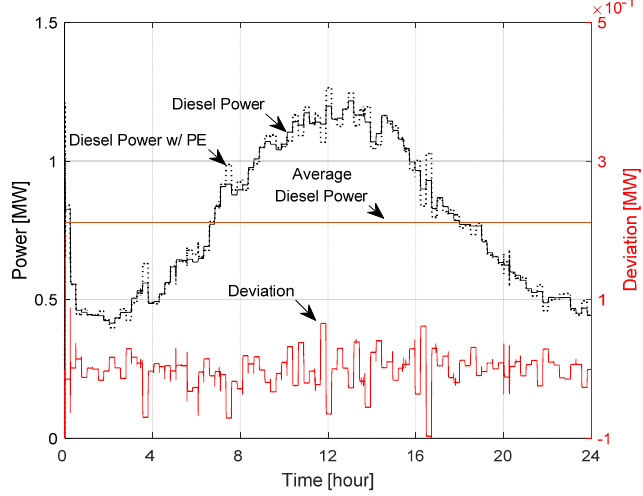
Figure 8. Diesel generator output comparison between two cases.